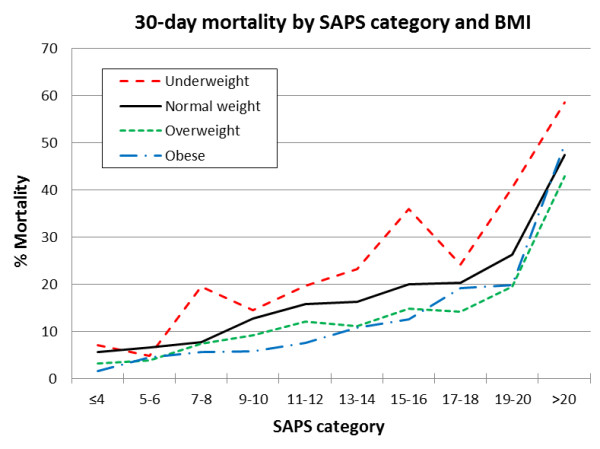
The 30-day mortality by SAPS category and BMI. Graph illustrating the differences in 30-day mortality based on the admission SAPS score and BMI category.